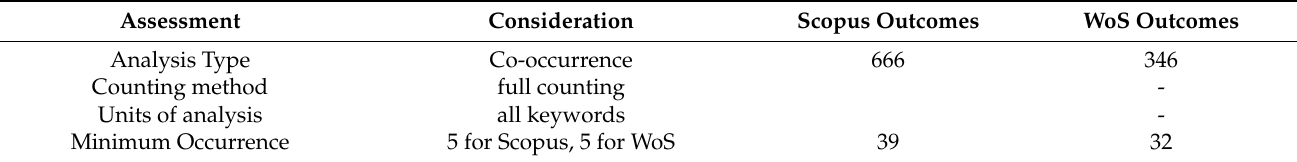
Table 4. Keyword’s co-occurrence